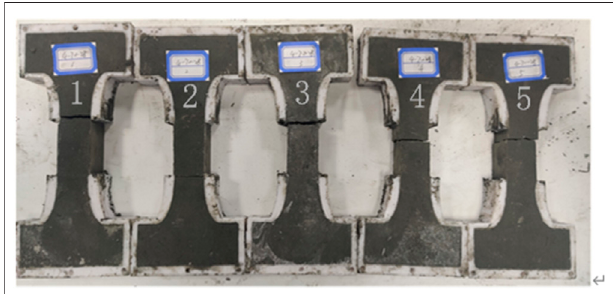
FIGURE 6 | Failure pattern of the sample S 70 B 20 T 28 .